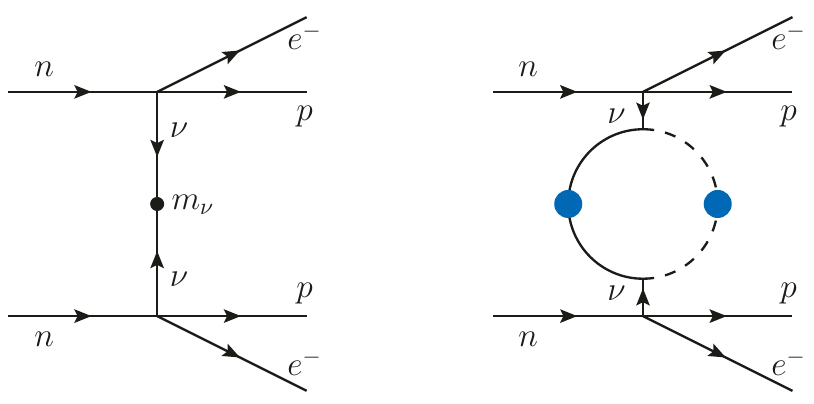
Figure 1 . Left: Feynman diagram of the standard 0 (cid:23)(cid:12)(cid:12) decay process; Right: Feynman diagram of a loop-enhanced 0 (cid:23)(cid:12)(cid:12) decay process, where the blue blobs represent LNV, cf. (cid:12)gure